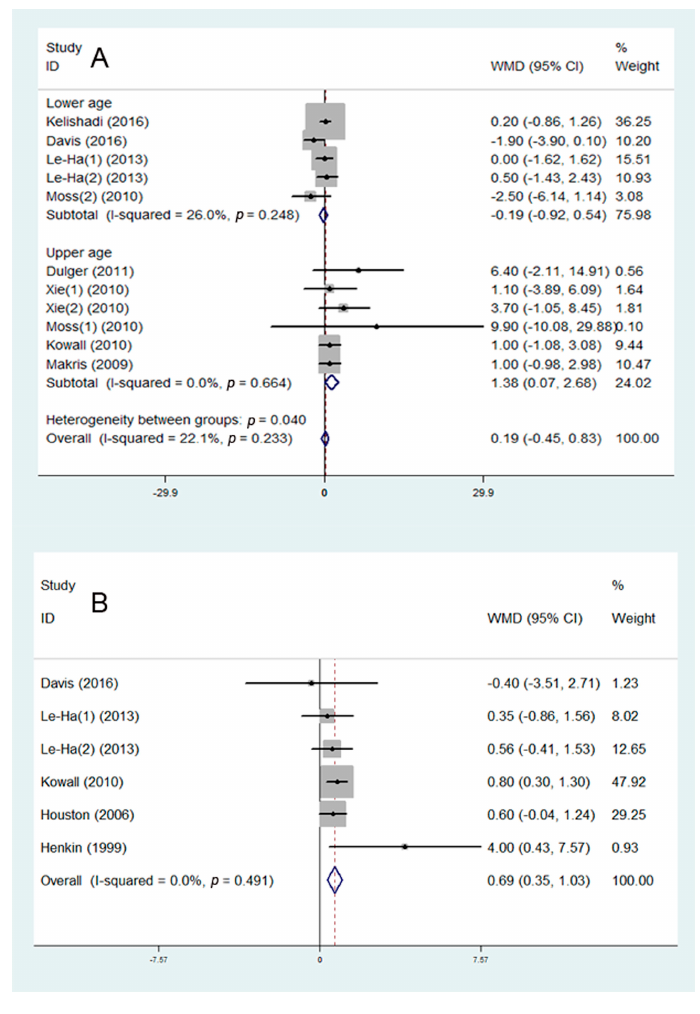
Figure 2. Meta-analysis of secondhand smoke (SHS) and risk of glucose metabolism disorder: ( A ) association between SHS and fasting plasma glucose (FPG); ( B ) association between SHS and insulin. WMD—weighted mean difference.